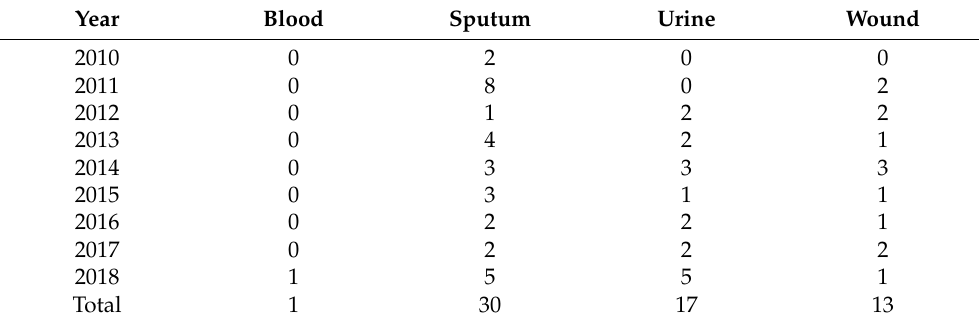
Table 2. Number of difficult-to-treat P. aeruginosa isolates per specimen per year.